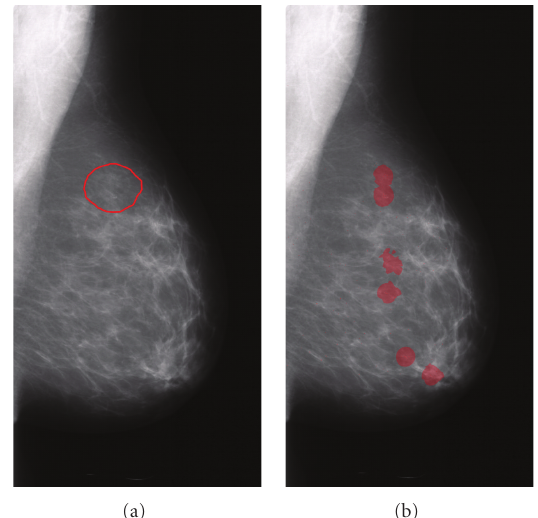
Figure 2: (a) Original DDSM mammogram with the expert radiologist’s mark surrounding the microcalcification cluster. (b) Mammogram showing the regions of interest generated by our system. The upper ROI accounts for the true